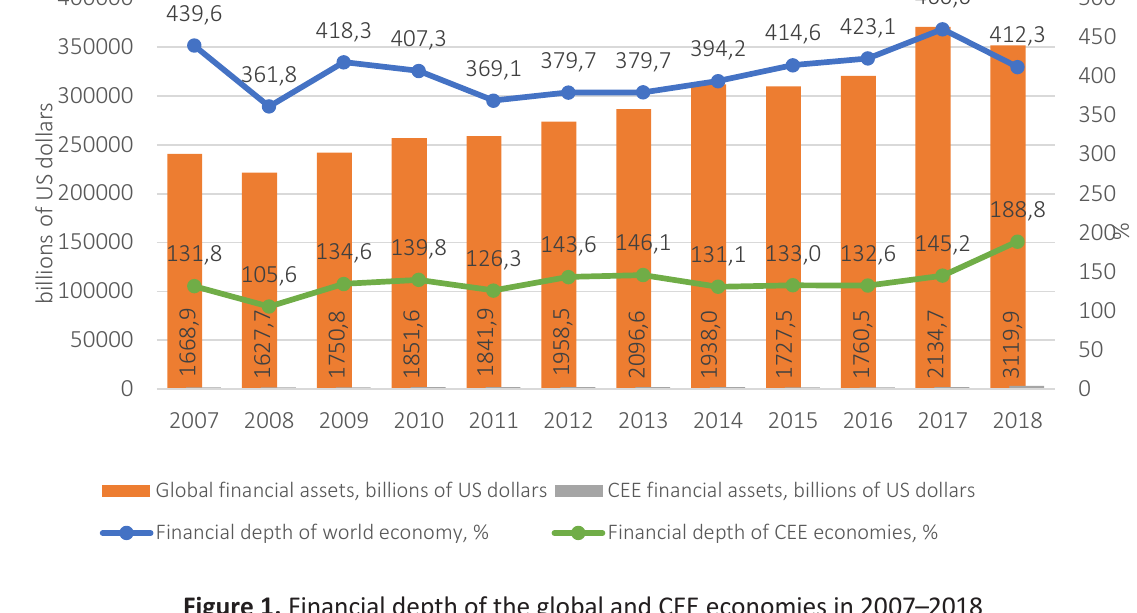
Figure 1. Financial depth of the global and CEE economies in 2007–2018